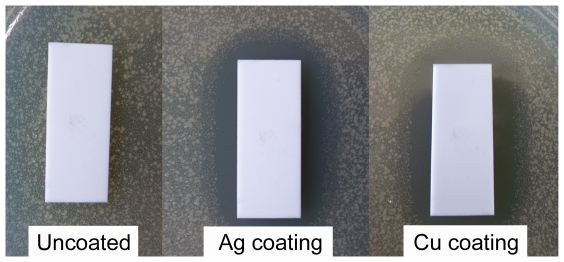
Diffusion method for E. coli for the uncoated and coated alumina substrates obtained at 740°C for n-Ag glass and at 850°C for the n-Cu glass.A similar result was obtained for zirconia substrates.